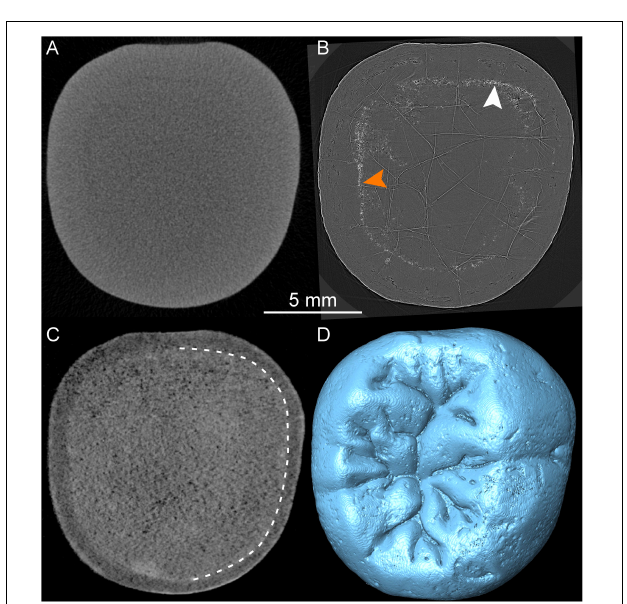
FIGURE 9 | X- µ CT- (A) , SR- µ CT- (B) , and n- µ CT-based (C) transverse virtual cross-sections of the crown of the lower molar Sangiran 7–65. The SR- µ CT-based 3D rendering of the crown occlusal morphology is shown in (D) . The white and orange arrows in (B) show the bright fringes produced by the phase contrast effect. The dotted line in (C) indicates the enamel-dentine boundary, not visible in (A) (X- µ CT) or (B) (SR- µ CT).